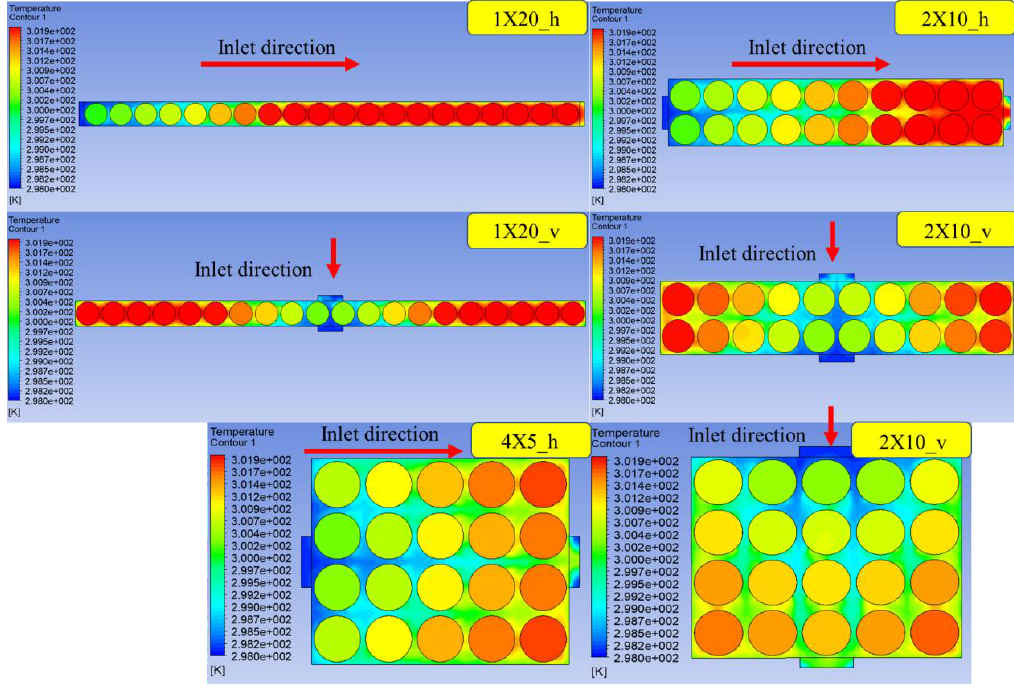
Figure 8. Temperature distribution of the battery layout schemes.